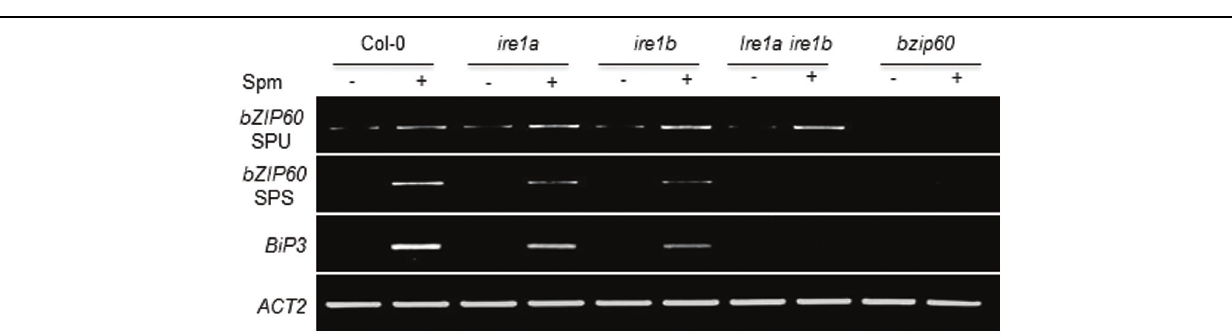
FIGURE 3 | Spm-induced bZIP60 splicing occurs in an IRE1-dependent manner. Ten-days-old seedlings of Col-0 (control), ire1a (SALK_018112, Deng et al., 2011, 2013; Nagashima et al., 2011) mutant, ire1b (SAIL_238_F07) mutant, and ire1aire1b double mutant, and bzip60 (SALK_050203) mutant were treated with half strength MS solution as a control (-) and half strength MS solution containing 0.5 mM Spm ( + ). Results of RT-PCR for expression analysis of SPU and SPS forms of bZIP60 and its downstream gene BiP3 were displayed. Actin was used as an internal